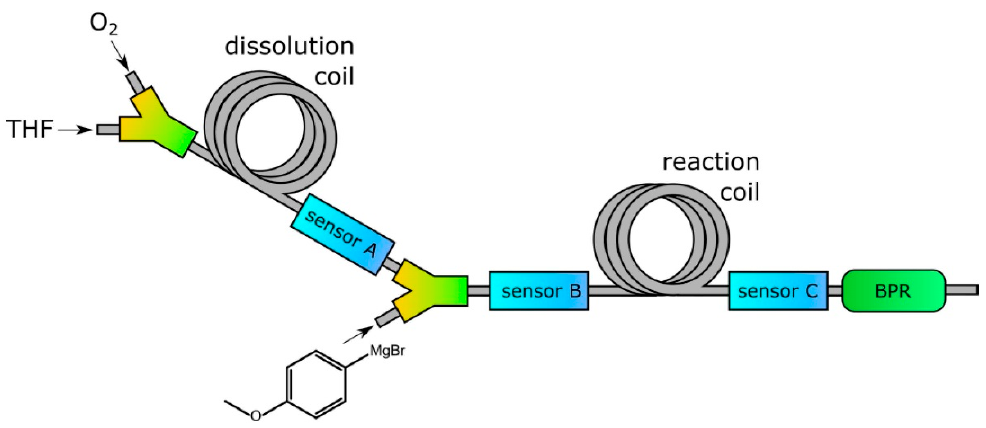
Figure 4. Scheme of the reaction setup including reagent inlet and two additional sensors before and after a reaction coil.